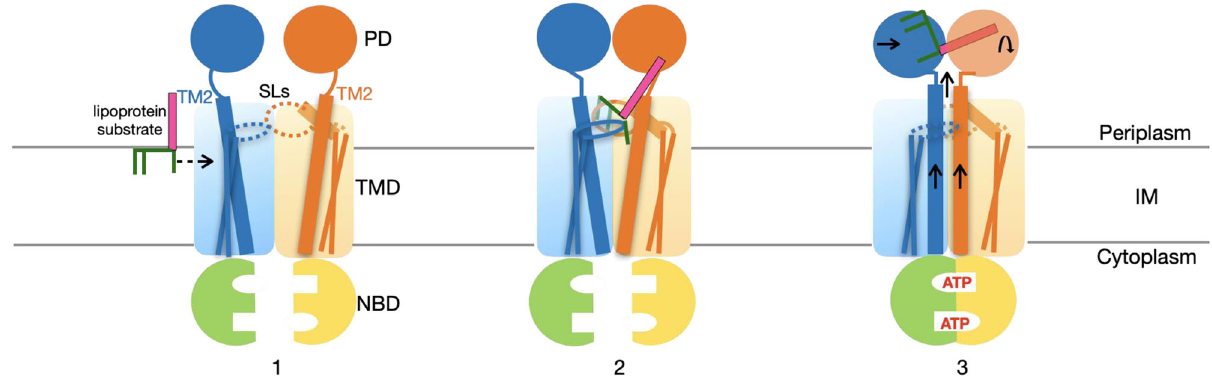
Fig. 5 Proposed model for LolCDE-driven lipoprotein extraction from the inner membrane of E. Coli . Lol proteins and lipoproteins are colored as in Fig. 1. See text for description of proposed steps for lipoprotein transport. SL shoulder loop (dotted oval), PD periplasmic domain, TMD transmembrane domain, NBD nucleotide-binding domain, IM inner